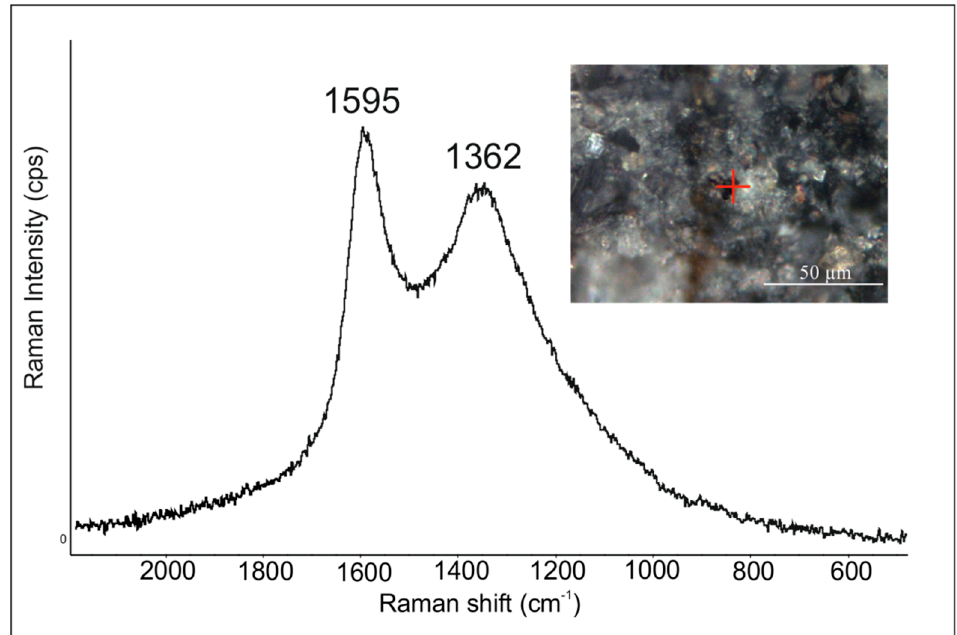
Figure 6. Microphotograph and Raman spectrum of low-grade carbonaceous material in the range of 2200–500 cm − 1 . Analytical spot was marked by red cross.